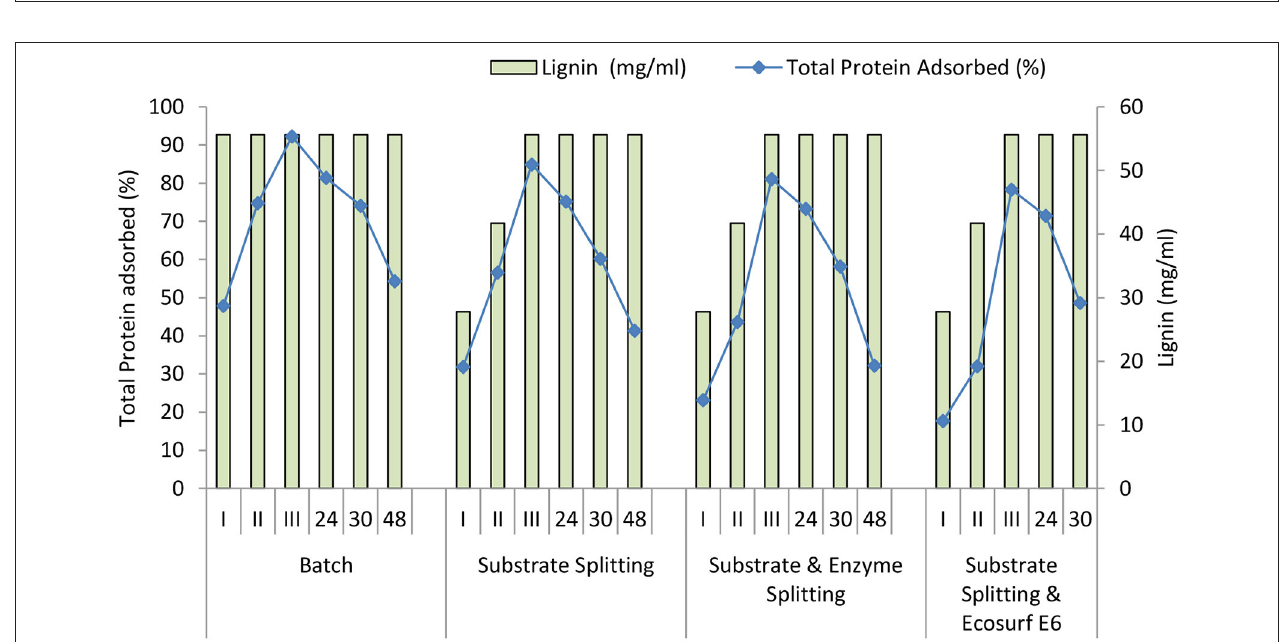
FIGURE 9 | Protein adsorption and lignin content during hydrolysis under different modes.